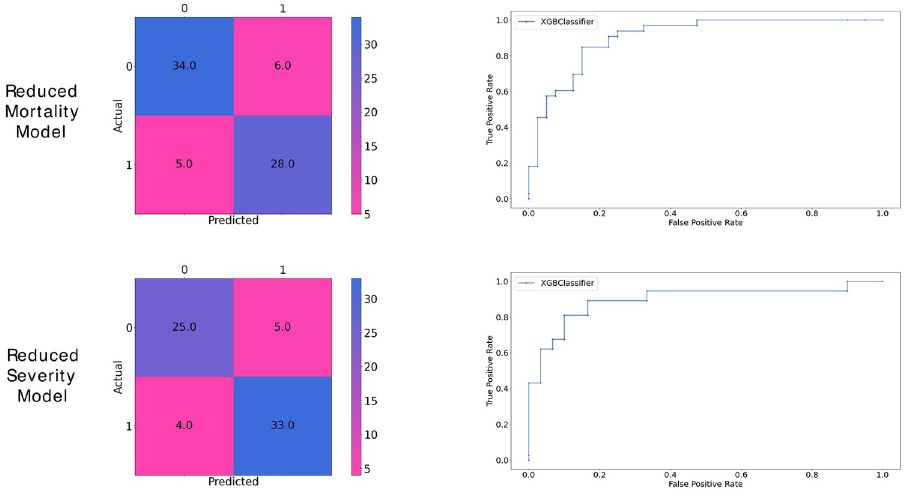
Fig 4. Confusion matrixes and ROC curve for the Reduced Mortality (top) and Severity prediction (bottom) models.